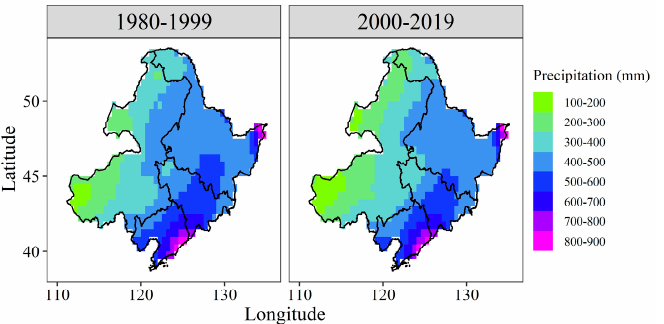
Figure A3. Change of precipitation during frost-free stage in the Northeast China Plain from 1980 to 2019.